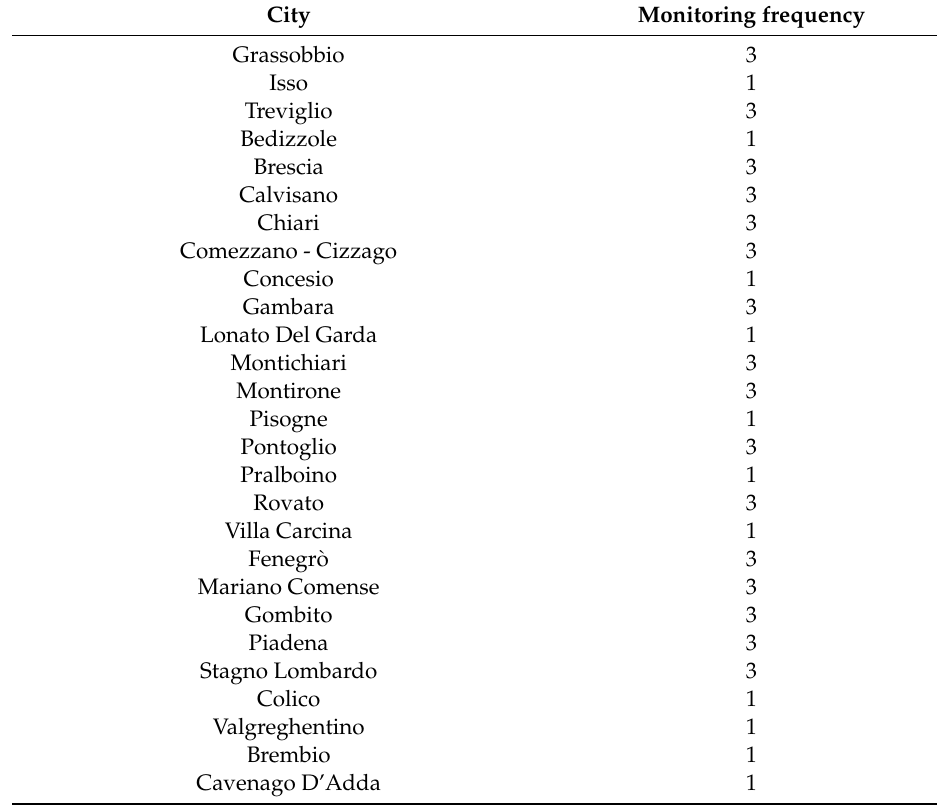
Table 5. Ground water sampling stations